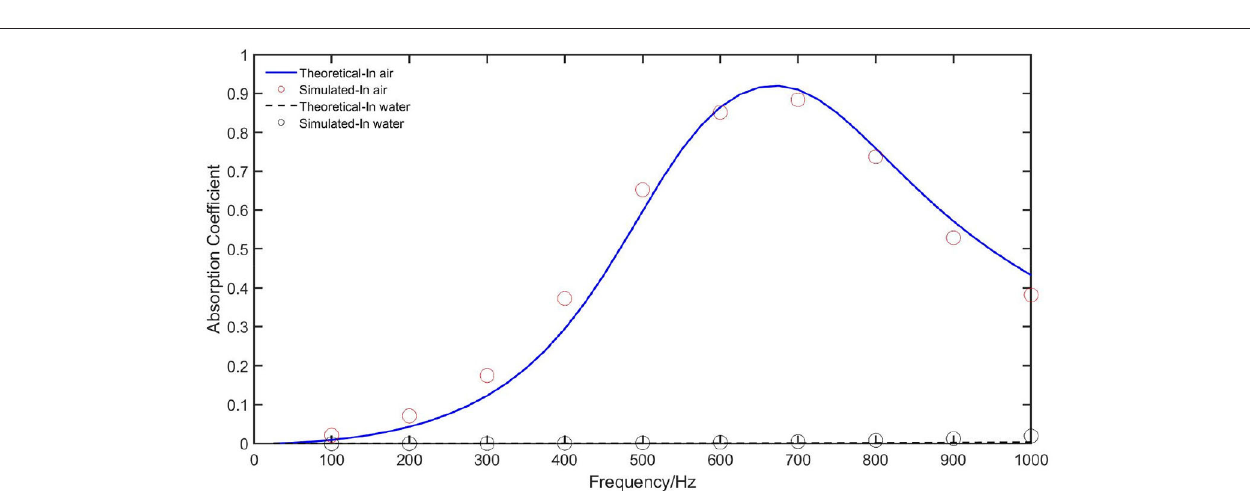
FIGURE 6 | Sound absorption coefficient of the all-aluminum structure in air and water.